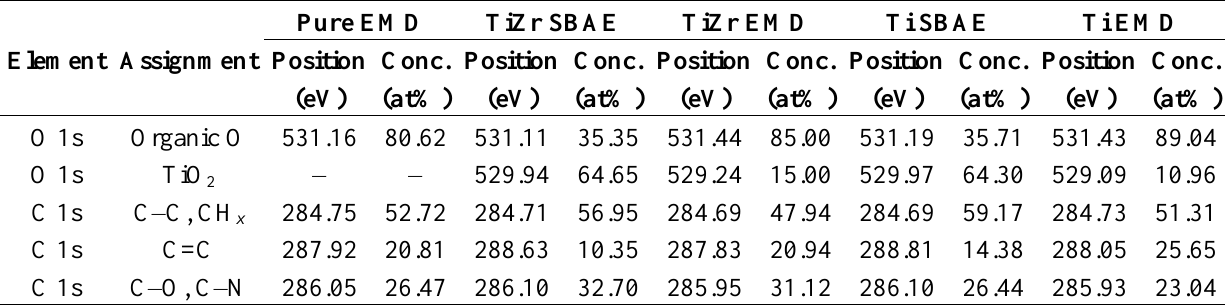
Table 3. XPS specific bindings of the surface oxygen and